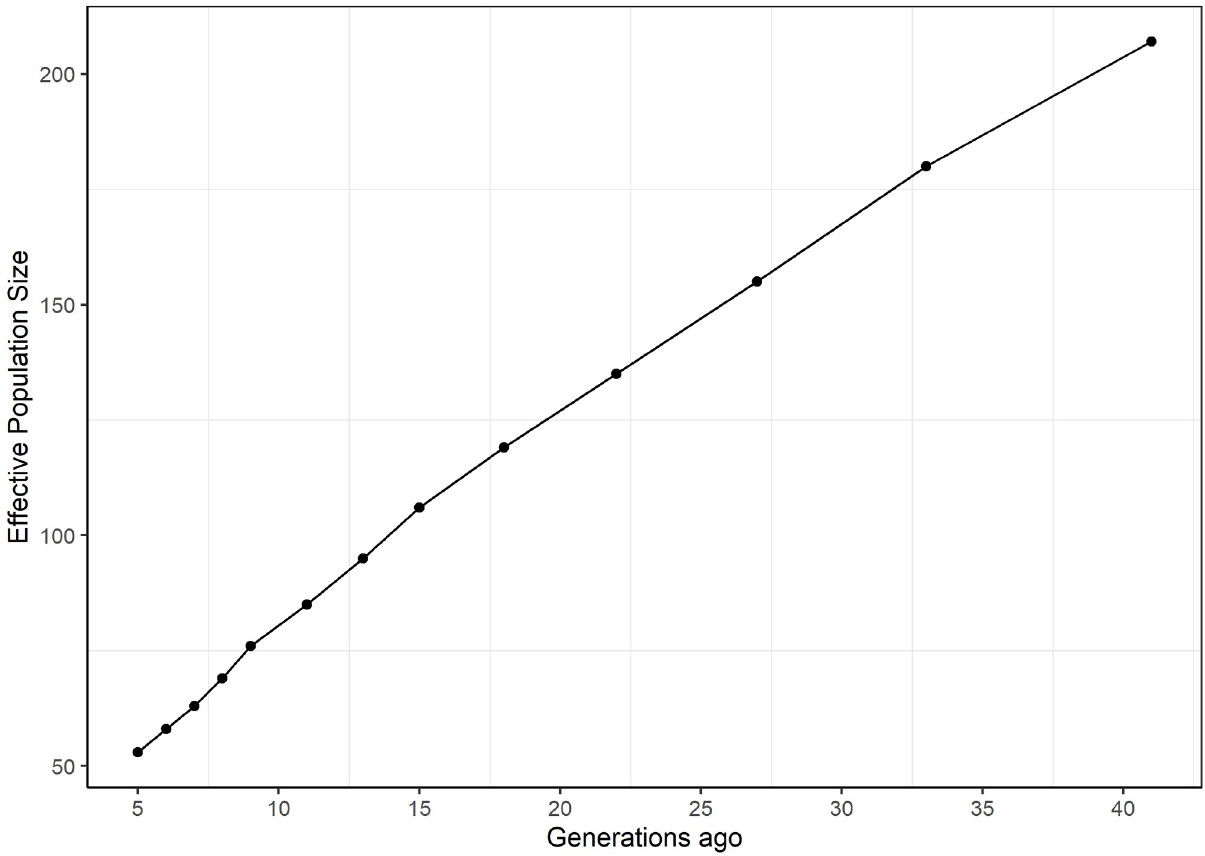
Fig 3. Trends in LD based effective population size across 41 generations of the German White-headed Mutton population.